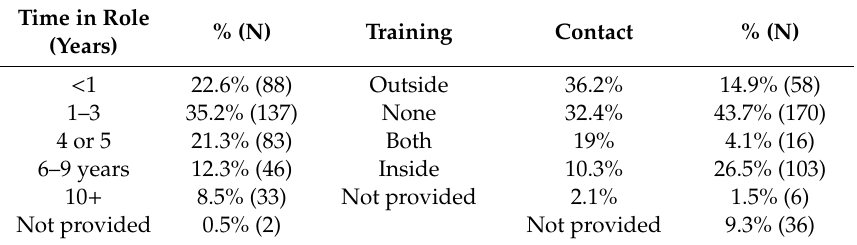
Table 1. Time in role and related